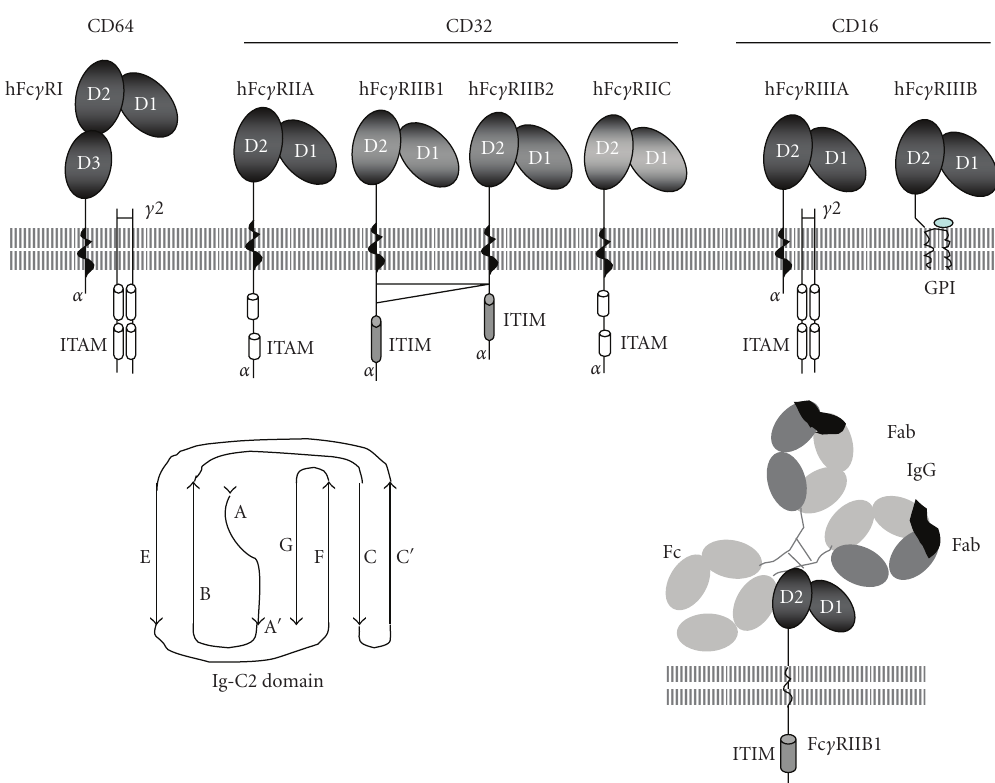
Figure 1: The human Fc gamma Receptors. Structure of Human Fc gamma Receptors CD64, CD32, and CD16. The Fc γ R belongs to the Ig superfamily and possess Ig-C2 types of extracellular domains. The domain D2 of the Fc γ RIIB binds to the hinge region of the IgG.